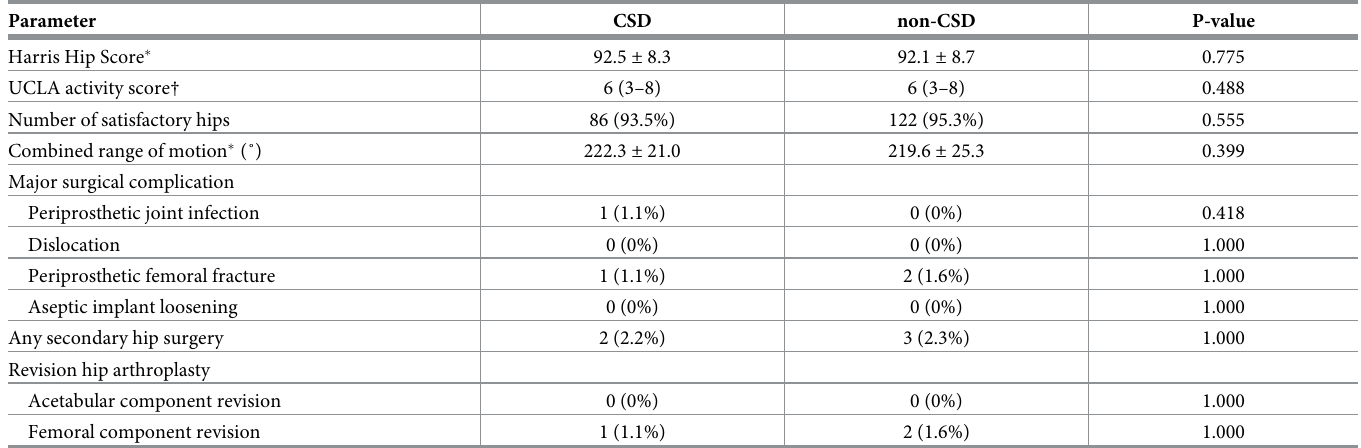
Table 4. Final surgical outcomes and